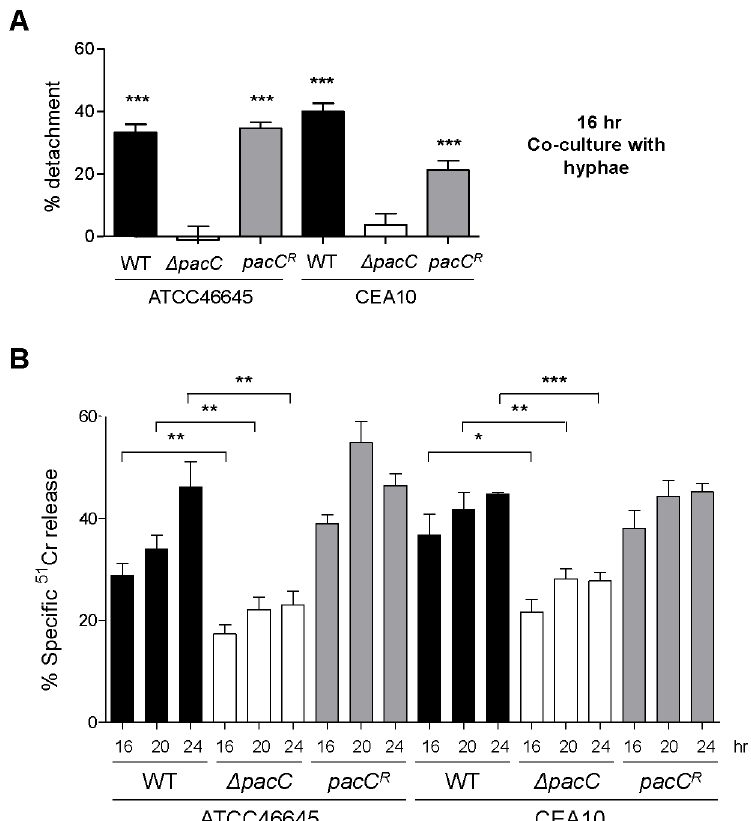
Figure 3. Quantitative analysis of epithelial integrity. (A) Percent detachment, relative to PBS challenge, quantified from a similar experiment as that depicted in Figure 1C. Significance was calculated relative to PBS-challenged A549 cells. (B) Quantification of A549 damage by 51 Cr release assay upon infection with A. fumigatus (5 6 10 5 spores/ml) for 16, 20 and 24 hr. A and B: technical and biological triplicate, unpaired t test. *** p , 0.001, ** 0.001 , p , 0.01, and * 0.01 , p , 0.05.